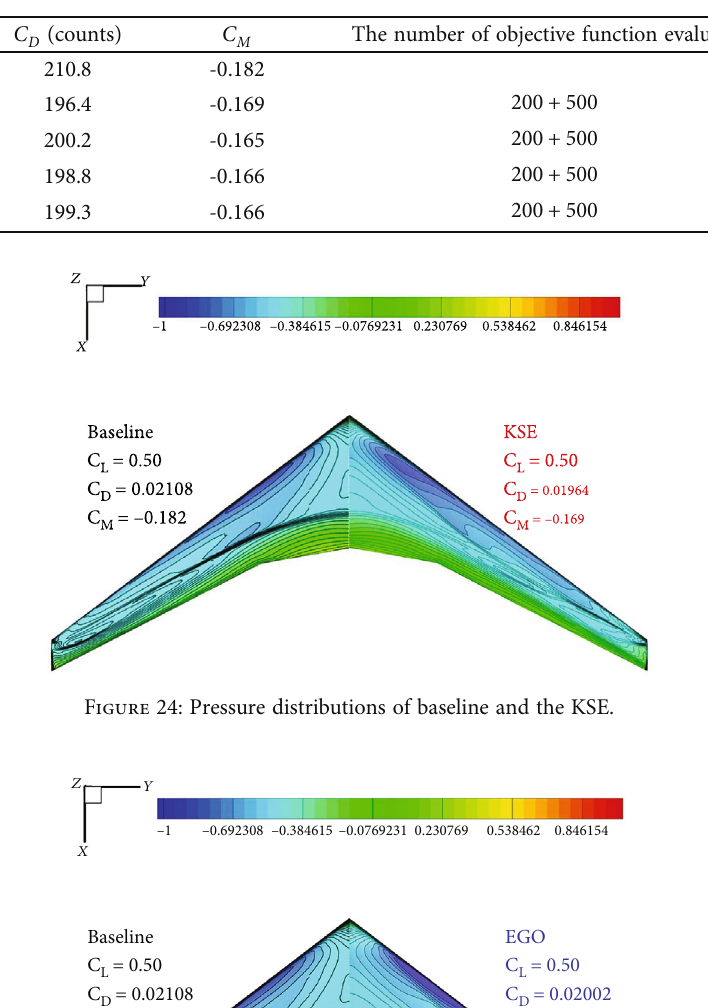
Table 8: The best result comparison of di ff erent methods.